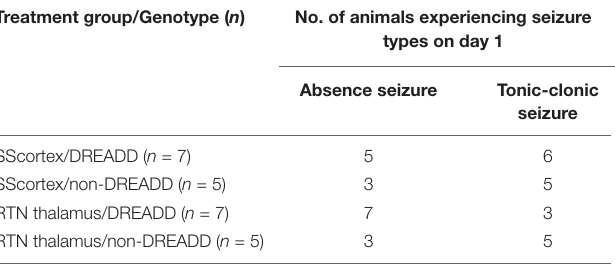
TABLE 2 | Number of animals exhibiting different seizure types on day 1 after PTZ